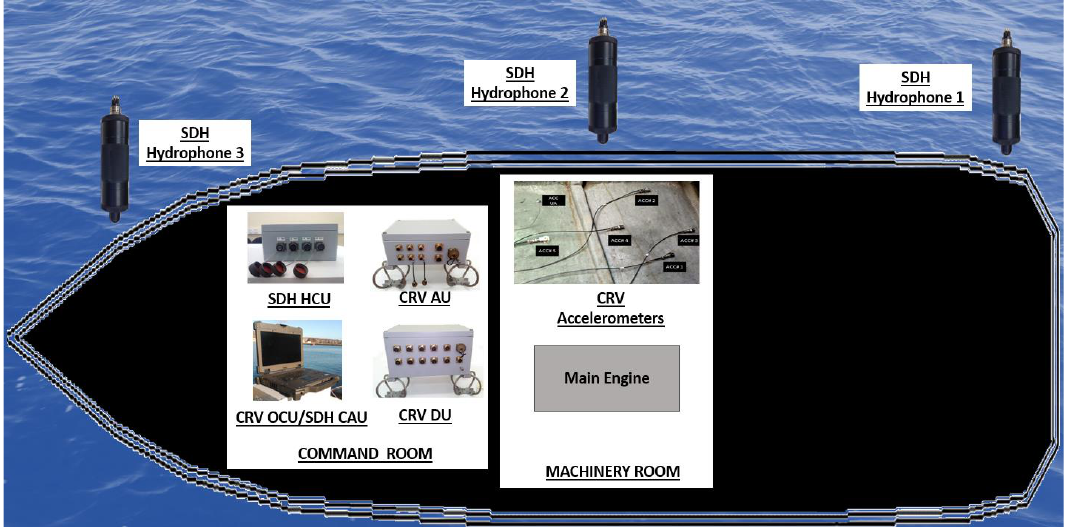
Figure 4. General diagram of the installed units and deployed sensors for the measurement of the vibrations and acoustical radiation of the hull and Underwater Radiated Noise (URN).